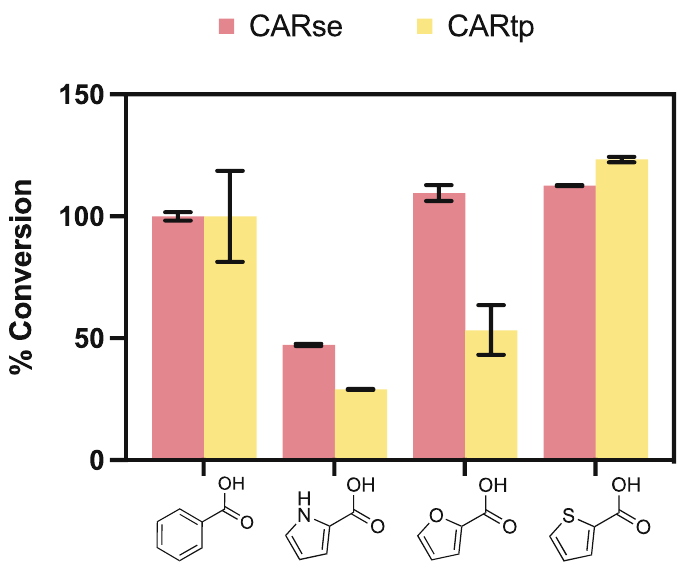
Figure 2. Relative percent conversion of CARse and CARtp against pyrrole-, furan-, and thiophene-2-carboxylic acids normalised against reduction of benzoic acid. Benzoic acid conversion (4.21 ± 0.06 mM and 2.88 ± 0.05 mM for CARse and CARtp, respectively) normalised at 100%. Performed at a 500ul scale in triplicate and analysed via HPLC, following 18 h of incubation at 30 °C.